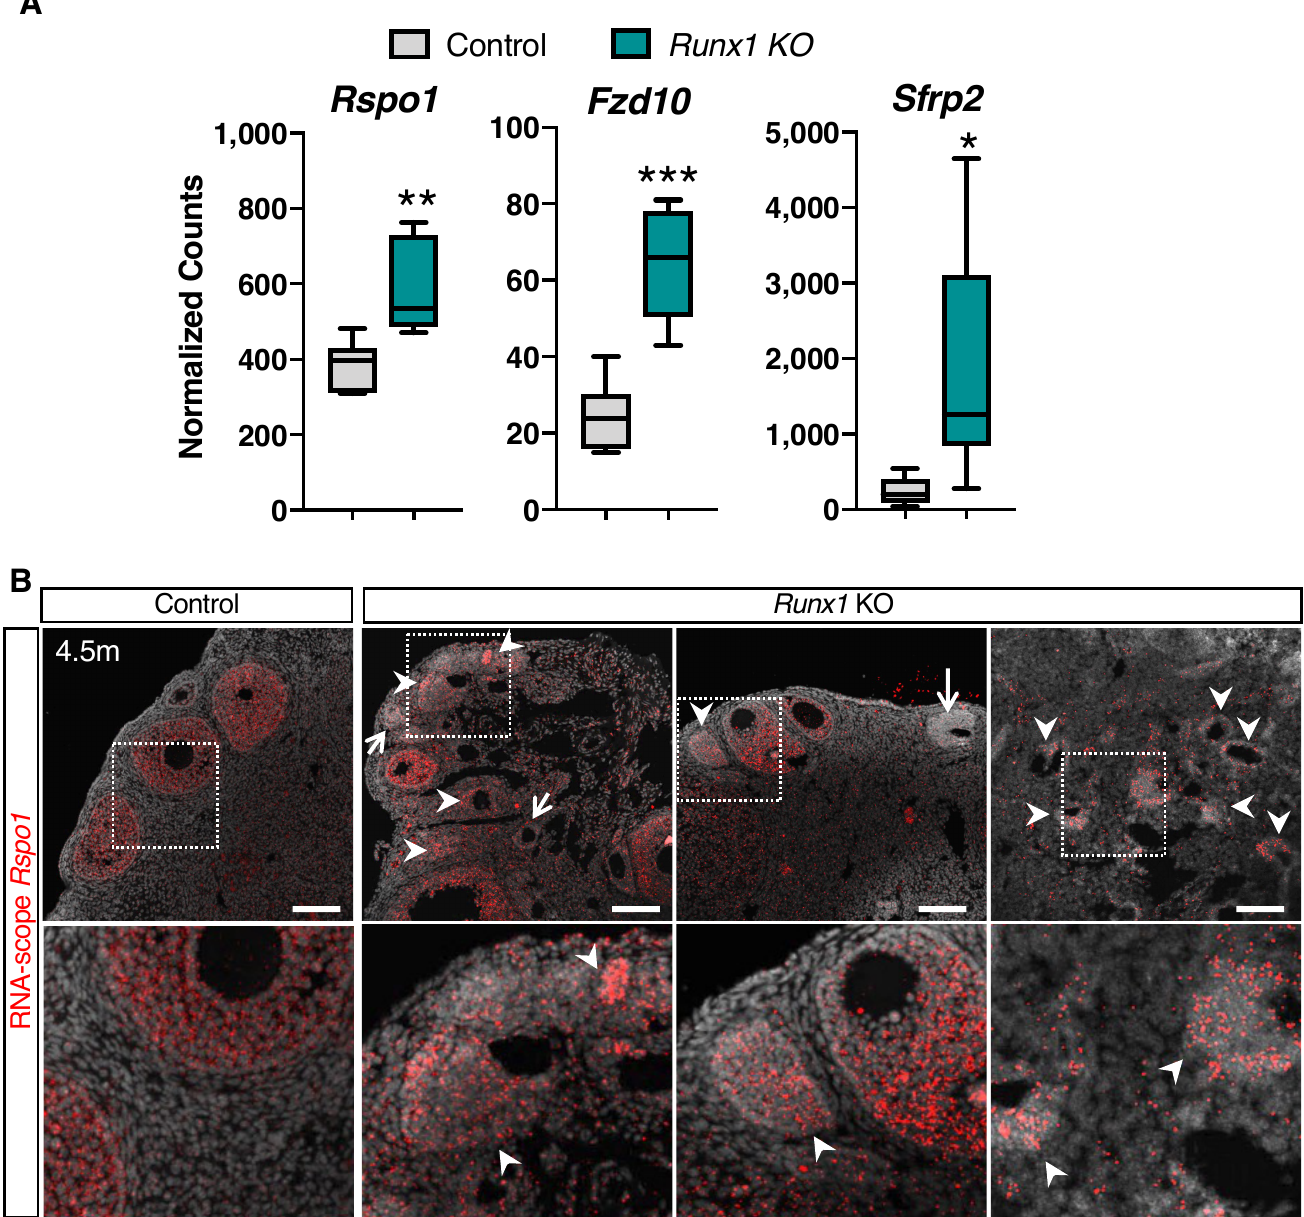
Figure 6. Upregulation of genes of the Wnt signaling pathway in Runx1 knockout ovaries. ( A ) Examples of significantly differentially expressed genes in Runx1 KO vs. control ovaries at 4.5 months. Boxplots represent the DESeq2-normalized counts from RNA-seq data. Values are presented as mean ± SEM ( n = 6/genotype); * p < 0.05; ** p < 0.01; *** p < 0.001. ( B ) RNA-scope